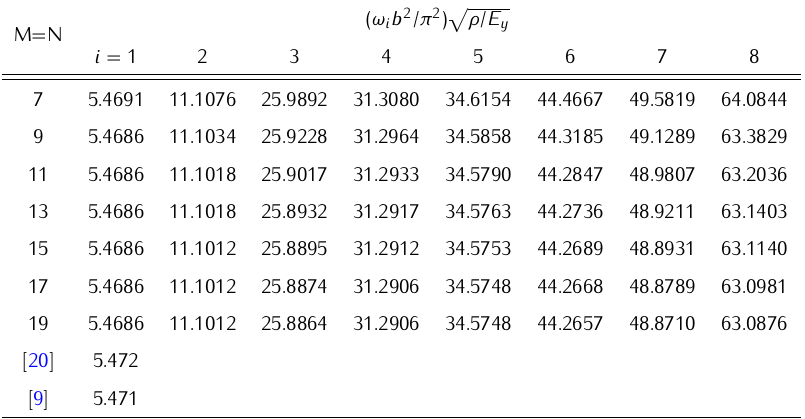
Table 1. Convergence study with respect to the results given by [20] and [9] for a cross-ply laminates ( for Boundary condition i.e. CCFF